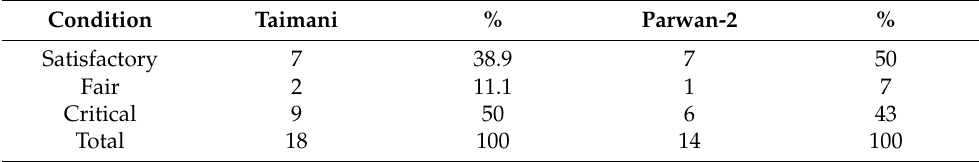
Table 14. Result of Study